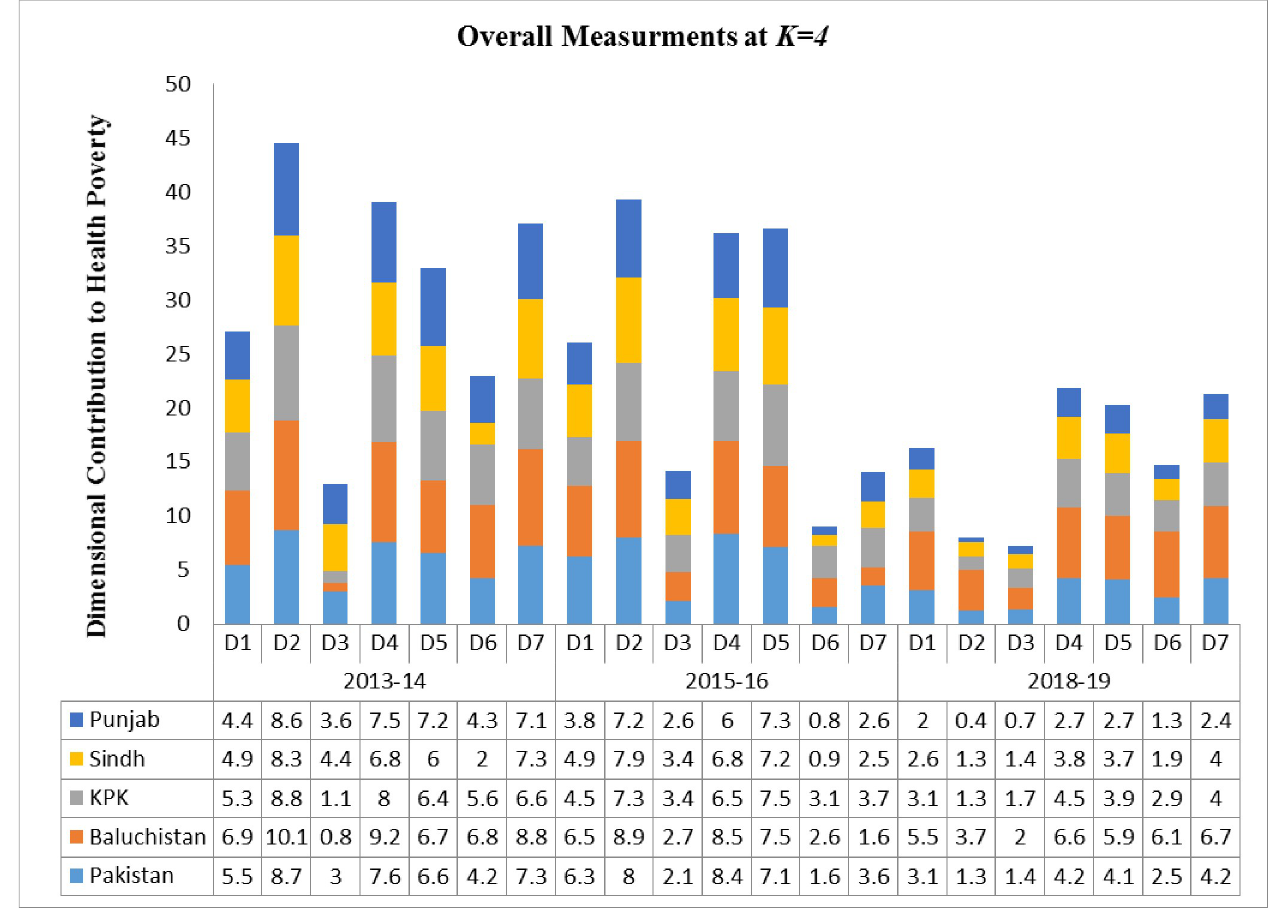
Fig 1. Dimensional decomposition of multidimensional health poverty (M o ) index through Shapley